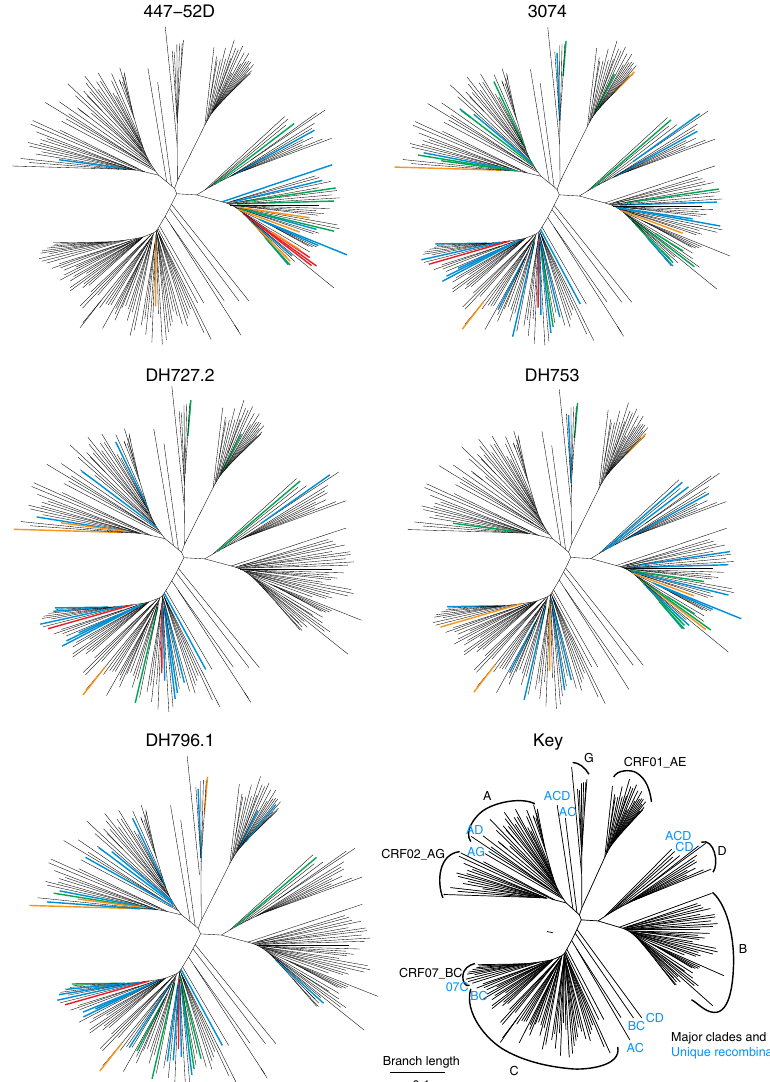
Fig. 2 HIV-1 phylogenetic trees indicate clade-speci fi c antibody neutralization patterns. These phylogenetic trees are based on the 208 pseudovirus panel, to allow direct visual comparisons of the vaccine-elicited antibodies with 447-52D. The HIV-1 envelope gp160 sequences were used to construct maximum likelihood trees, each HIV-1 clade is indicated in the key. Circulating recombinant forms (CRFs) 30 are indicated when they are major epidemic lineages: CRF02 is an AG recombinant that is A-like in Env and common in West Africa, CRF01 is an AE recombinant that is E-like in Env and common in southeast Asia, and CRF07 is a BC recombinant that is C-like in Env that is common in China. Unique recombinants are indicated in the dendrogram with blue letters indicating the parental virus clades. Neutralization IC50 titers for HIV-1 infection of TZM-bl cells are shown for two HIV-1 antibodies from natural infection (447-52D and 3074; top row) and vaccine-induced antibodies (DH727.2, DH753, DH796.1; bottom row). Neutralization potency is color-coded based on IC50 in µ g mL ‒ 1 as red 0.001 – 0.01, orange 0.01 – 0.1, green 0.1 – 1, blue 1 – 50 and black > 50. Of note is both the clade speci fi city of these antibodies, and the recurrence of the same subsets of viruses being sensitive within each clade. Source data are provided as a Source Data fi